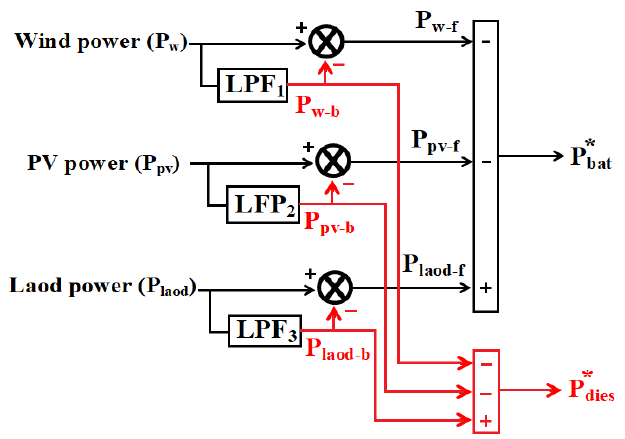
Figure 6. DG and battery power reference extraction method, where “*” indicate the references of the batteries P bat and diesel P dies powers.